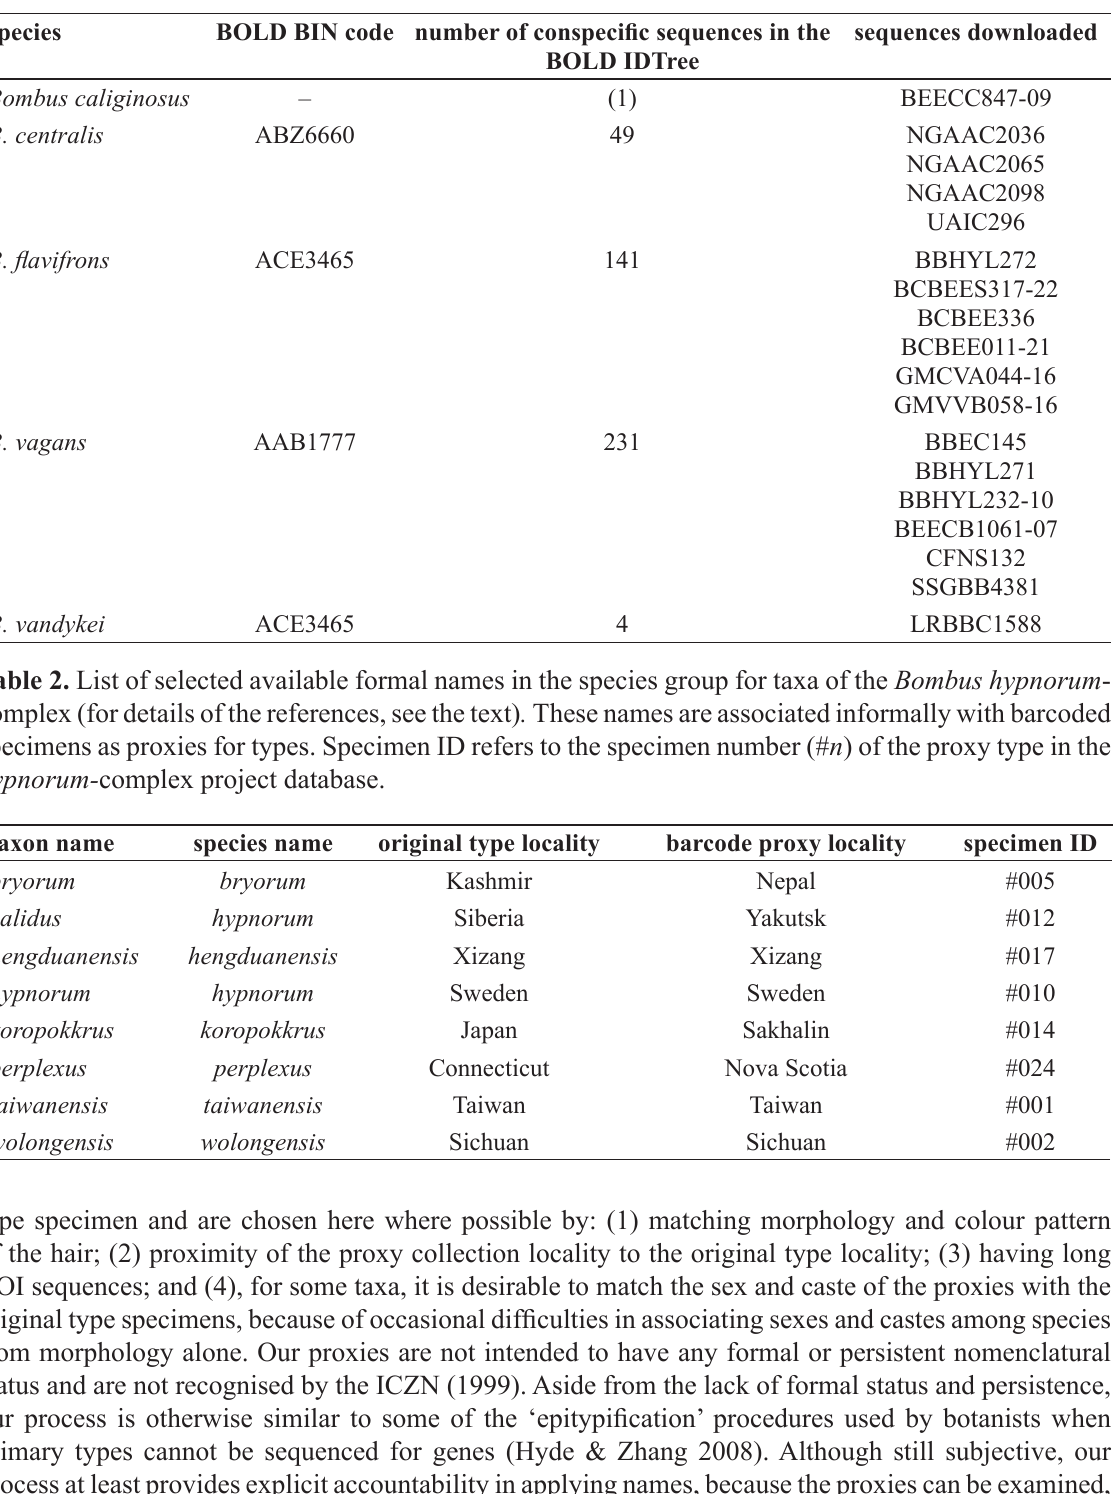
Table 1. BOLD sequences for species of the Bombus vagans -group accessed by BOLD BIN codes (Ratnasingham & Hebert 2013).